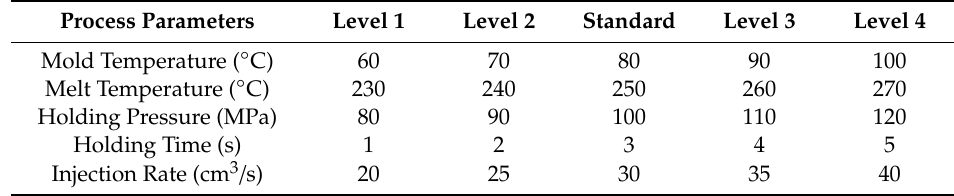
Table 2. The single-factor experimental program.